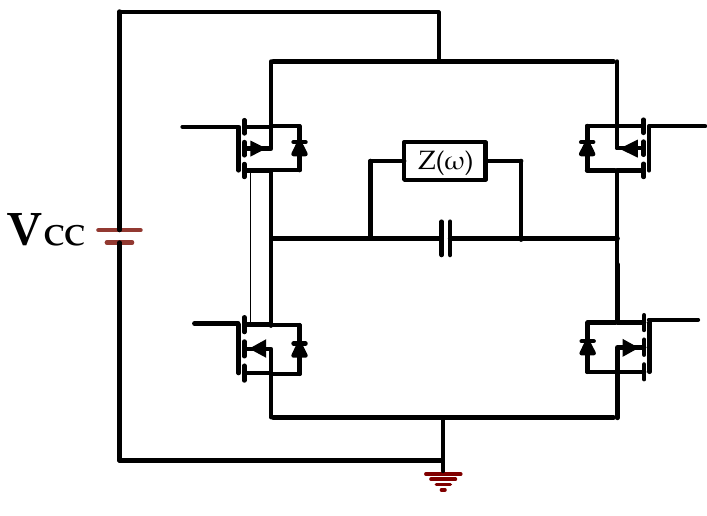
Figure 2. Equivalent circuit of H bridge.